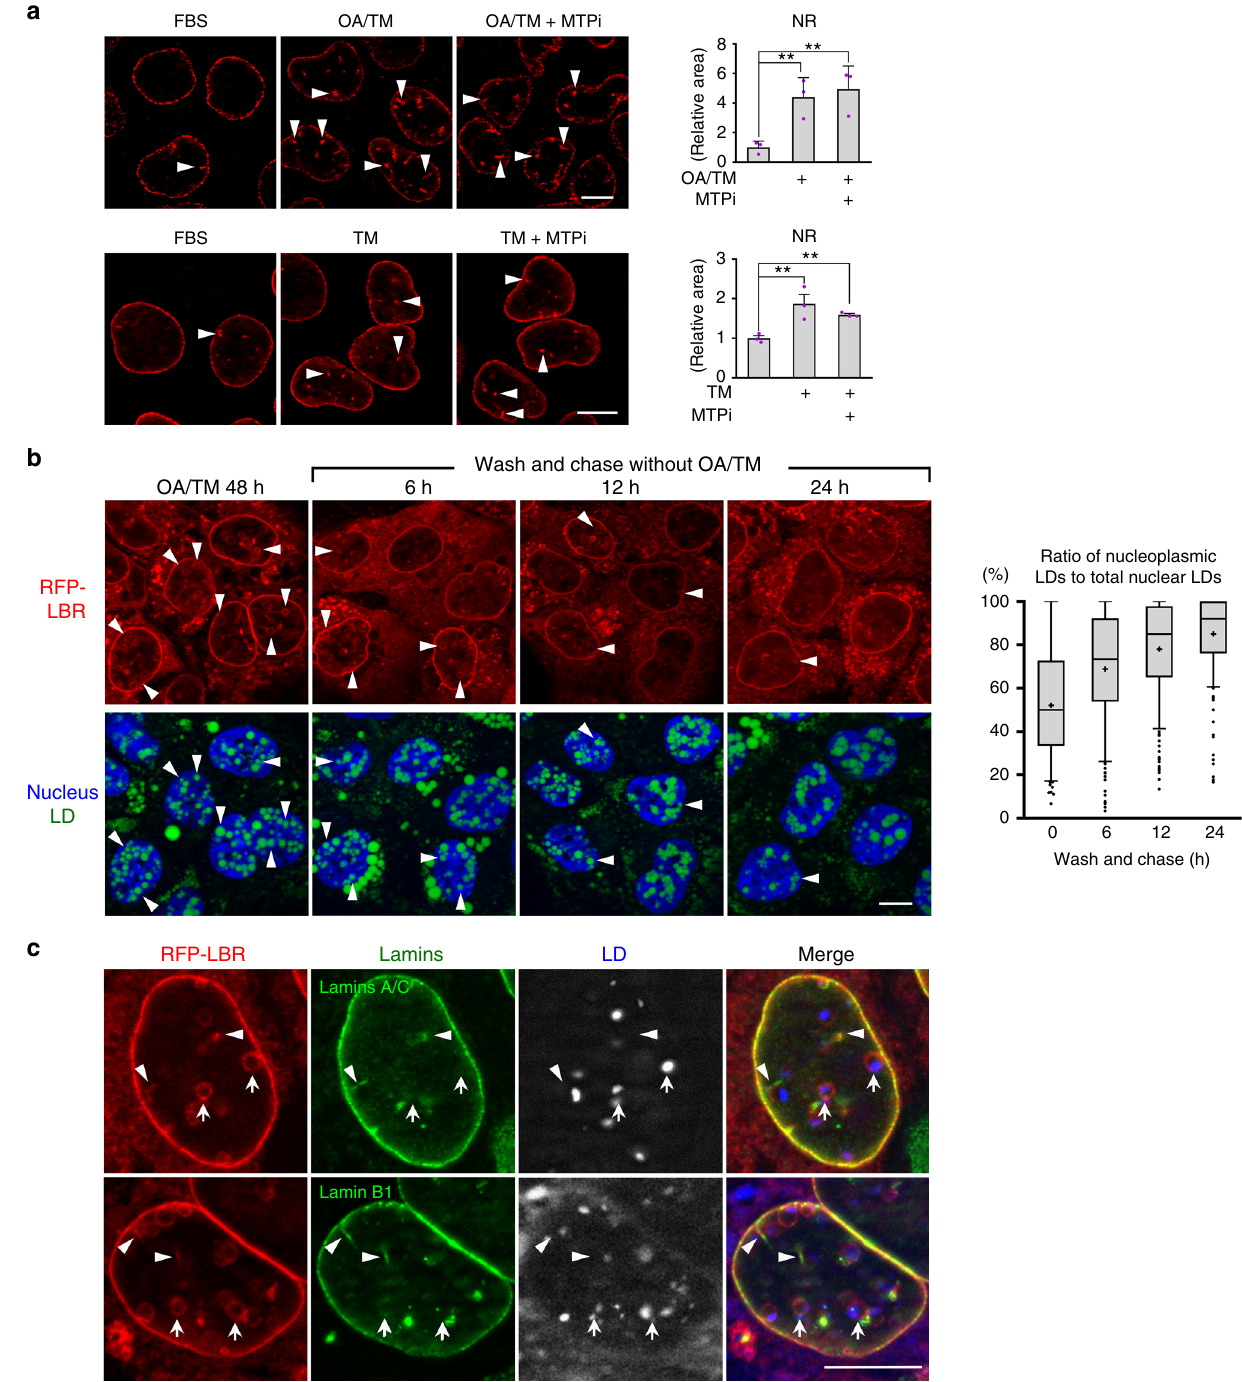
Fig. 4 MTP inhibition does not affect the development of NR. a The NR (red, endogenous LBR; arrowheads) increased in Huh7 treated for 48 h with OA/ TM (upper panel) or TM alone (lower panel), and the increase was not suppressed by MTPi (100 n M BAY 13-9952). Mean ± SD of three independent experiments. ** p < 0.05, one-way ANOVA followed by Tukey's test. See also Supplementary Fig. 4b. b The increase of nucleoplasmic LDs after OA/TM washout. Huh7 pretreated with OA/TM for 48 h was chased in a fresh medium. Shrinkage of the NR (red, RFP-LBR; arrowheads) caused an increase of nucleoplasmic LDs and a decrease of NR-lumenal LDs. LDs (green), nucleus (blue). Box plot of pooled data from three independent experiments. The average is shown by + . Number of nuclei counted: 194 (0 h), 187 (6 h), 209 (12 h), and 172 (24 h). c De fi ciency of lamins in the LBR ring. Lamin A/C and lamin B1 (green) were labeled in the linear NR portion (arrowheads) and along the nuclear periphery, but not in the ring-shaped NR around NR-lumenal LDs (arrows). Huh7 treated with OA/TM for 48 h. RFP-LBR (red). a – c Bars, 10 μ m. Source data are provided as a Source data fi